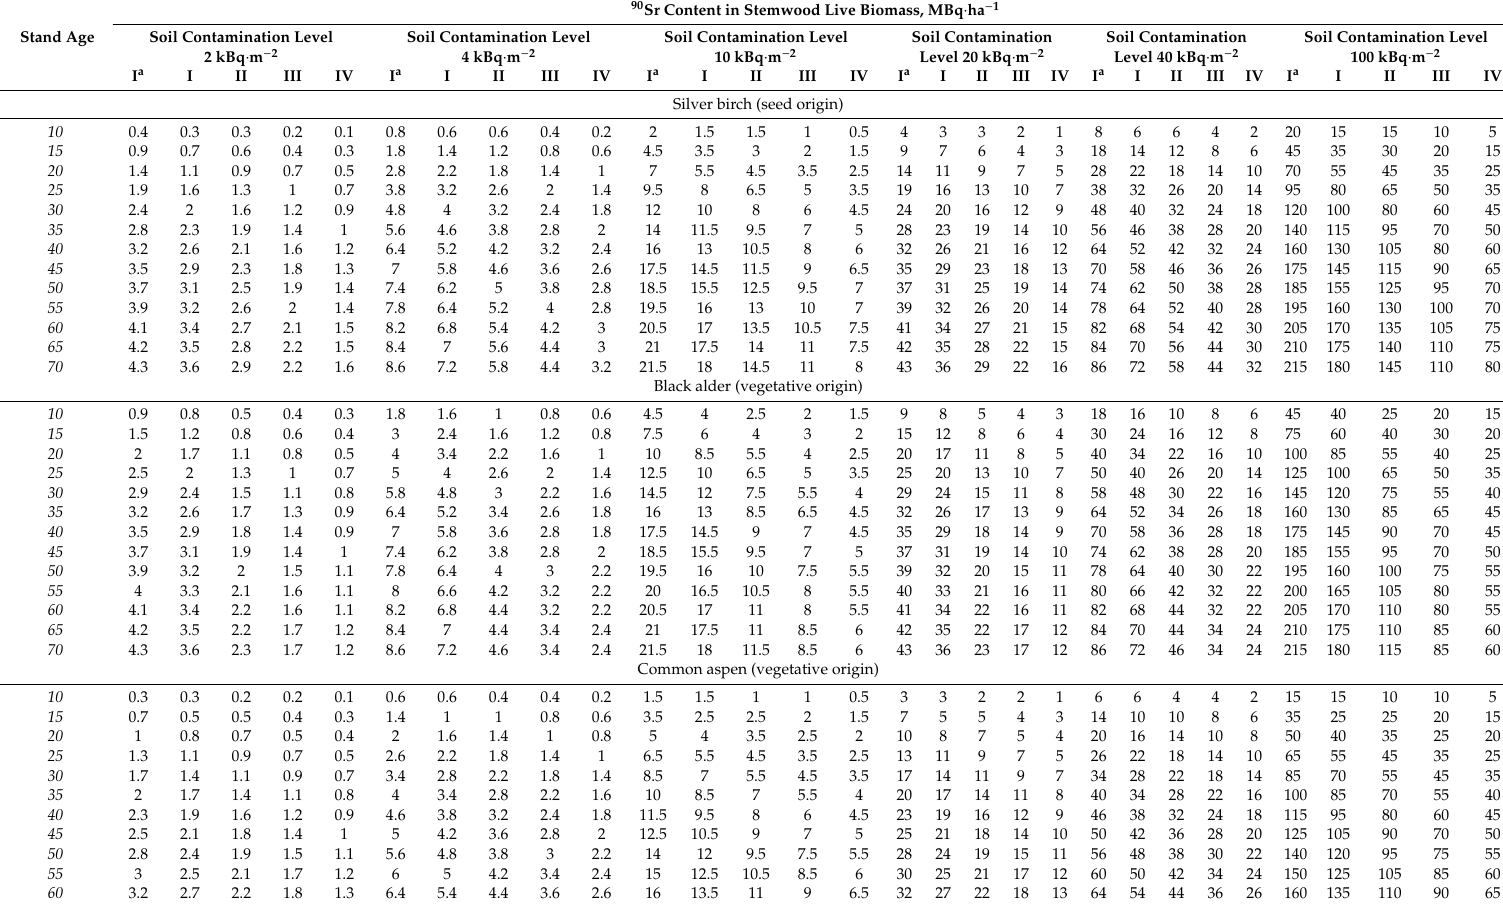
Table A2. Support tables of 90 Sr content in stemwood live biomass of various stand age, tree species, and site